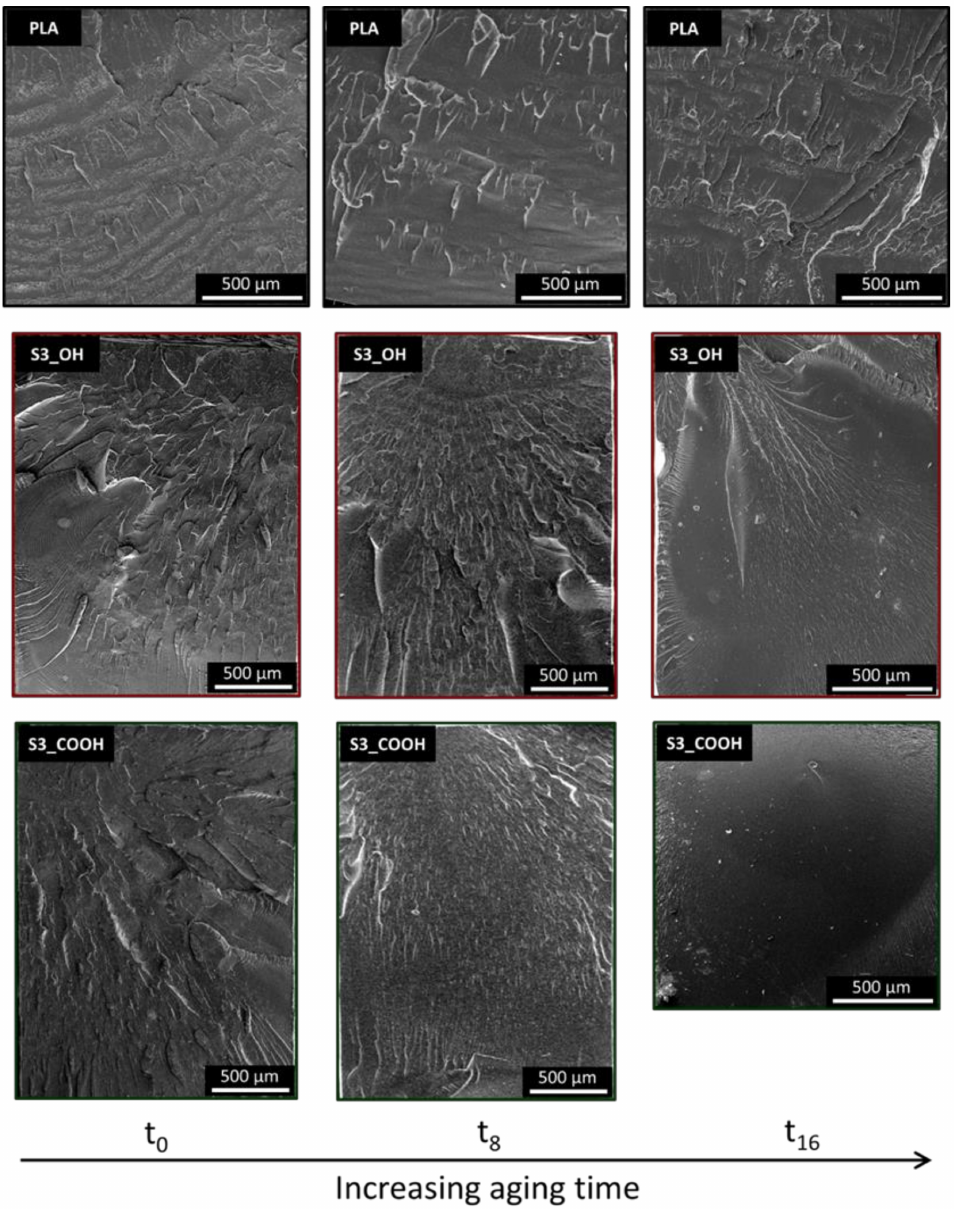
Figure 6. SEM micrographs of representative samples at different aging times. Fracture propagation direction is from the upper to the lower side of each